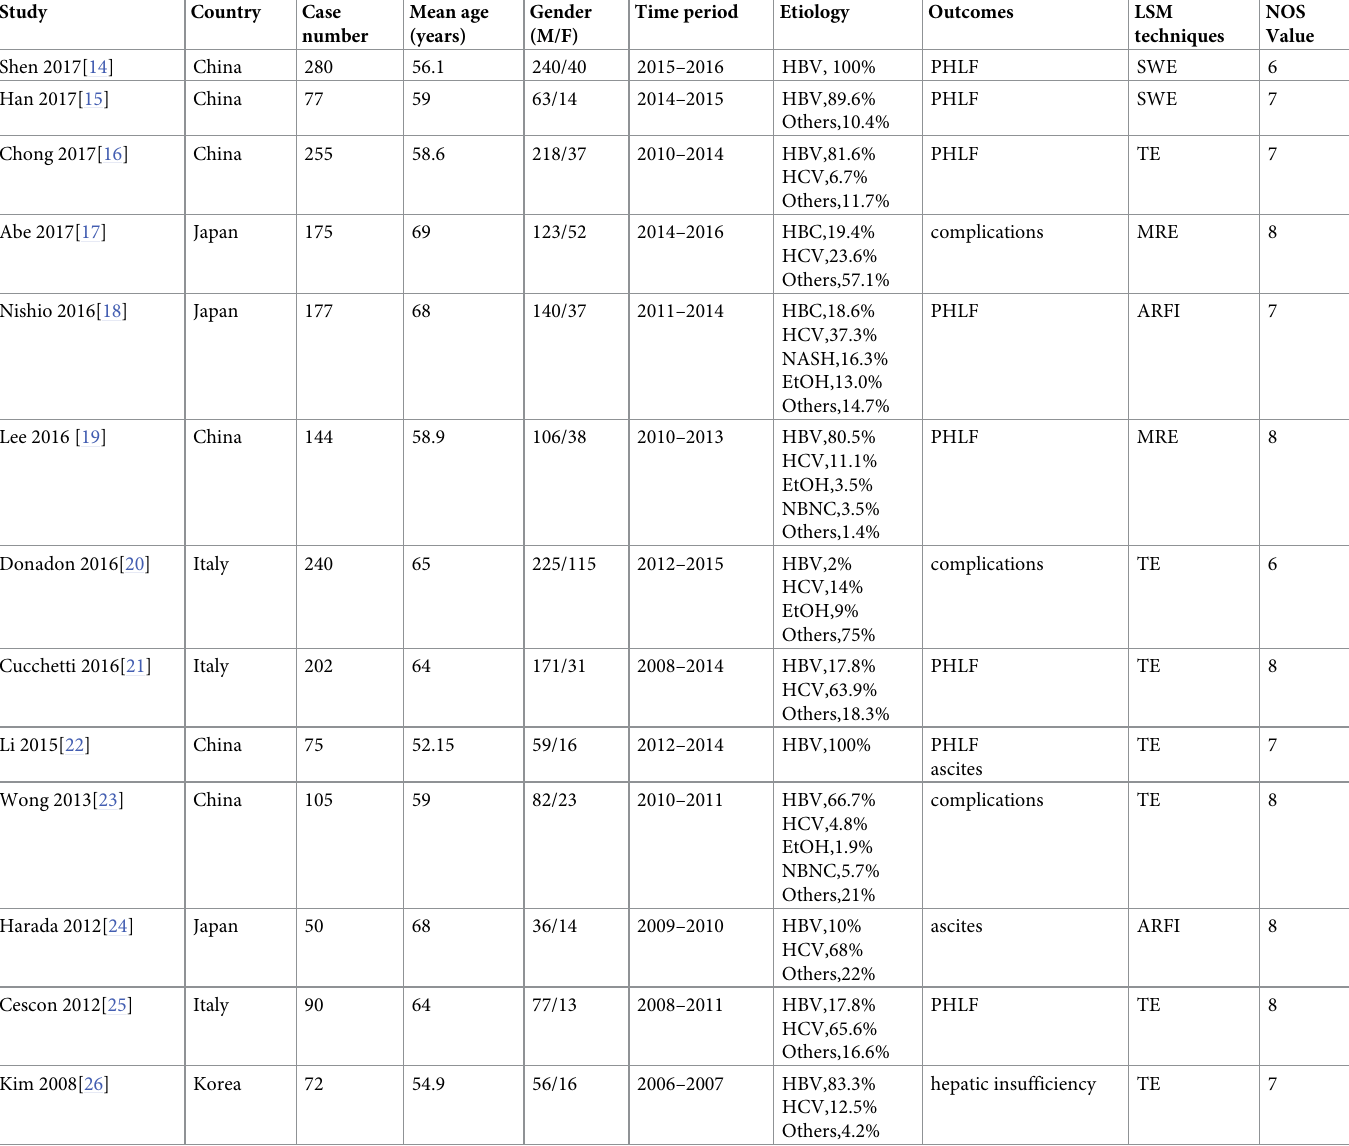
Table 1. The fundamental features of the included